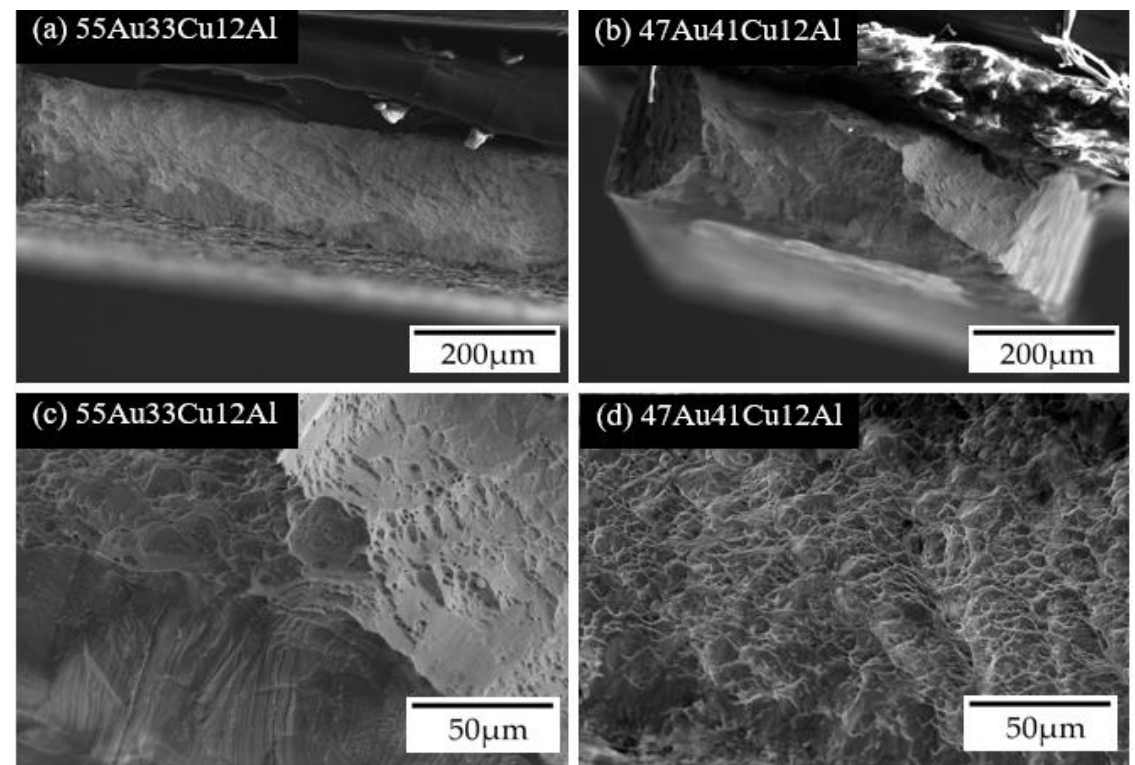
Figure 6. The cross-section SEM images and the zoomed-in images of ( a , c ) 55Au33Cu12Al and ( b , d ) 47Au41Cu12Al alloys.